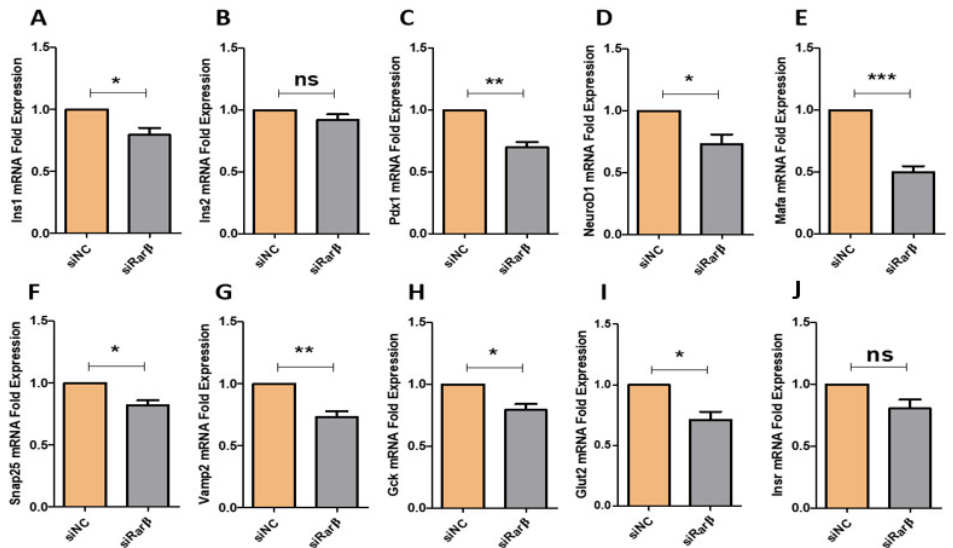
Figure 4. Impact of Rar β -silencing on β -cell function genes at mRNA level. qPCR was performed in si Rar β or negative control cells at 48 h after transfection. ( A ) Ins1 , ( B ) Ins2, ( C ) Pdx1, ( D ) NeuroD1, ( E ) Mafa, ( F ) Snap25 , ( G ) Vamp2 , ( H ) Gck , ( I ) Glut2, and ( J ) Insr . Data acquired from 3 independent experiments. *: p < 0.05, **: p < 0.01 and ***: p < 0.001. Bars represent mean ± SD.